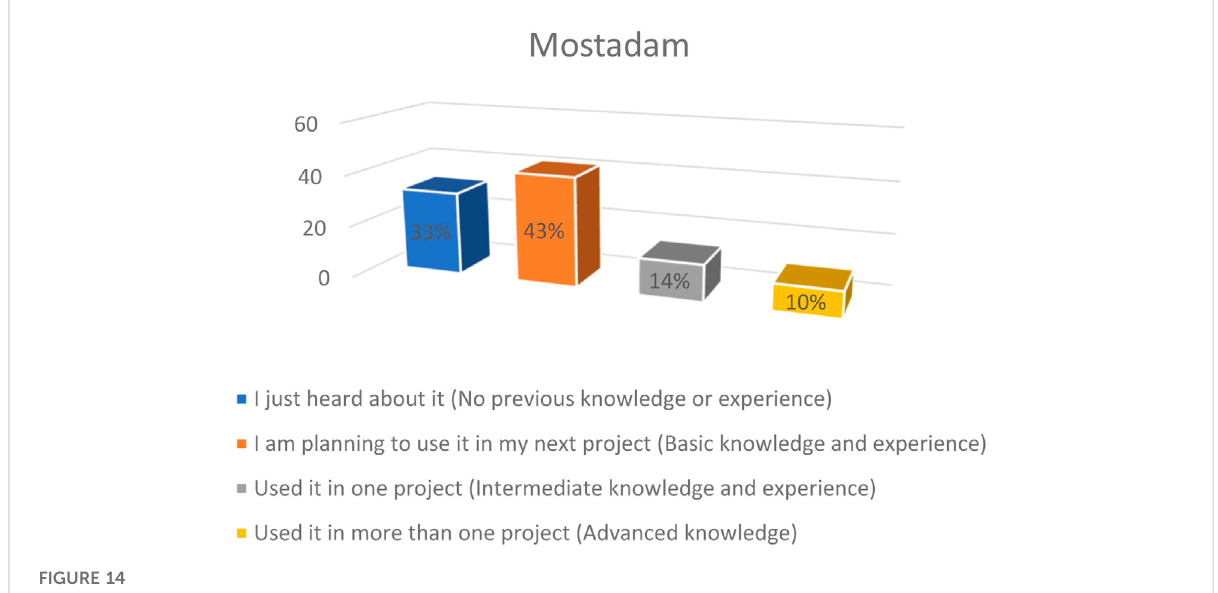
FIGURE 14 Knowledge and level of experience about Mostadam.